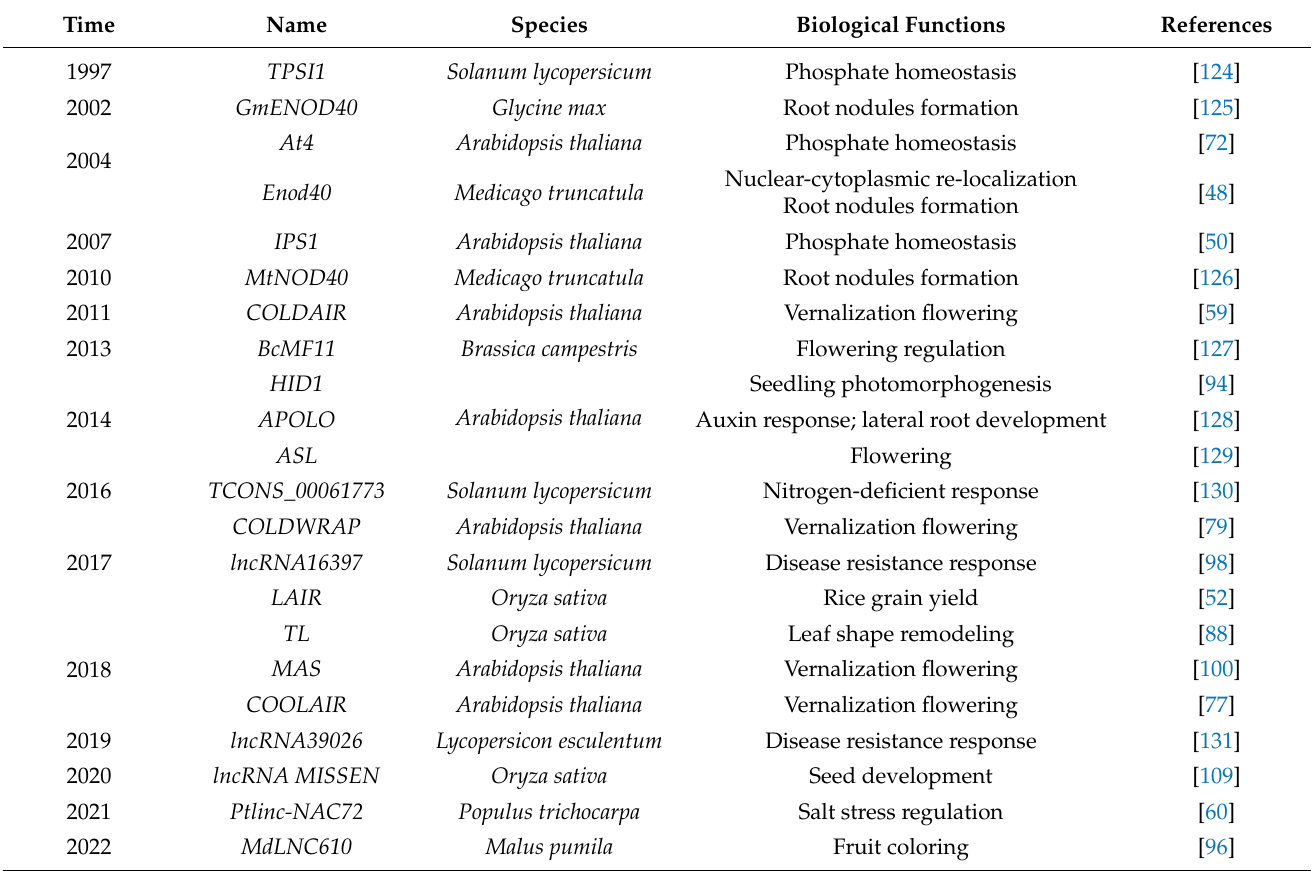
Table 2. Discovery and function analysis of